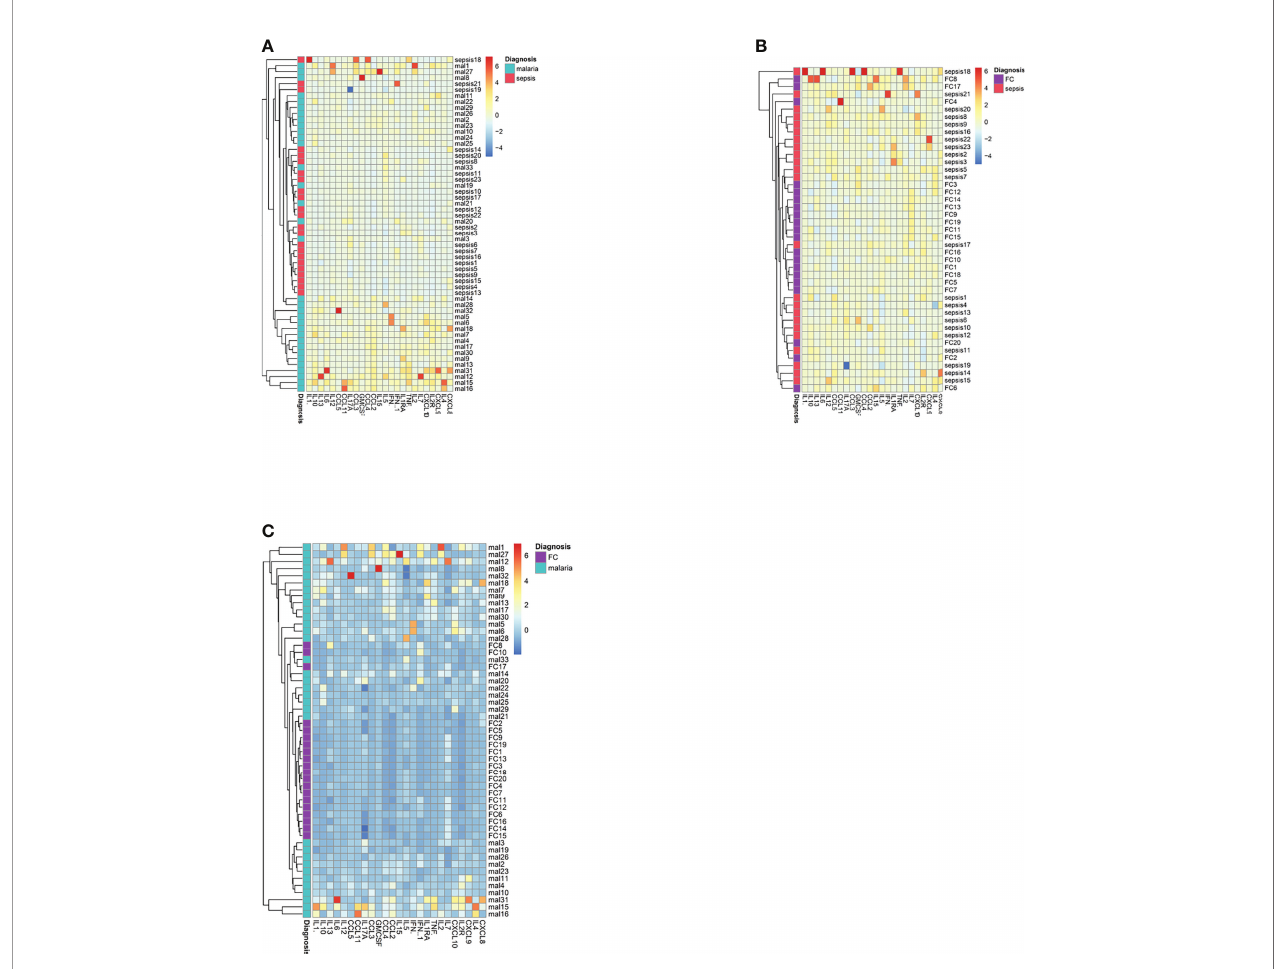
FIGURE 4 | A heatmap of the plasma levels of cytokines and chemokines in the patients with sepsis, malaria and febrile controls. The heatmaps depict the ability to separate (A) sepsis patients from malaria patients; (B) sepsis patients from febrile controls and (C) febrile controls form malaria patients.